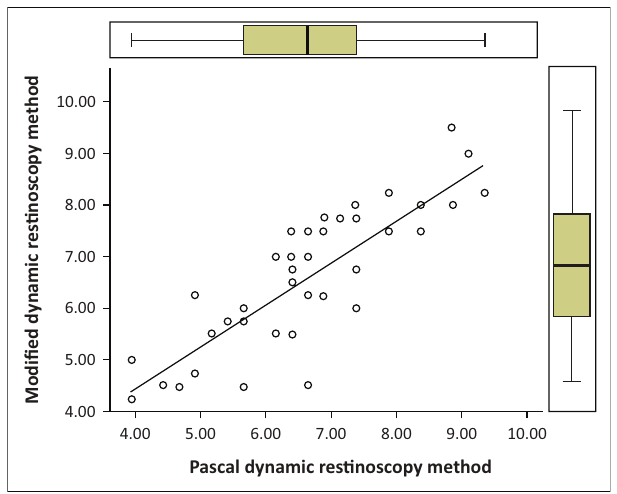
FIGURE 4: Scatter plot of modified dynamic retinoscopy against Pascal dynamic retinoscopy techniques, with the line of equality indicated. Correlation coefficient between the two methods was r , 0.83 ( p = 0.00). The regression equation is expressed as modified DR = 1.199 + 0.796 (Pascal DR).